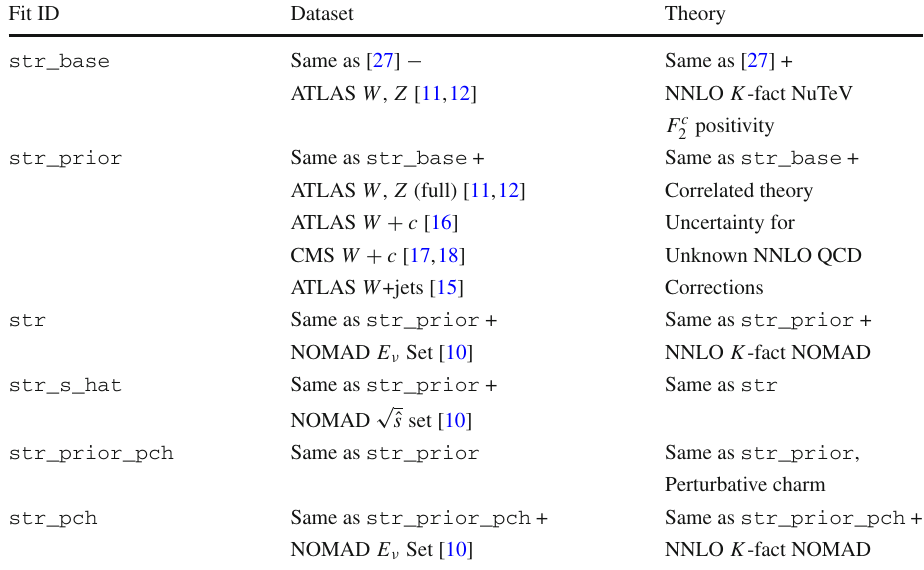
Table 1 A list of the PDF fits presented in this work; see the text for